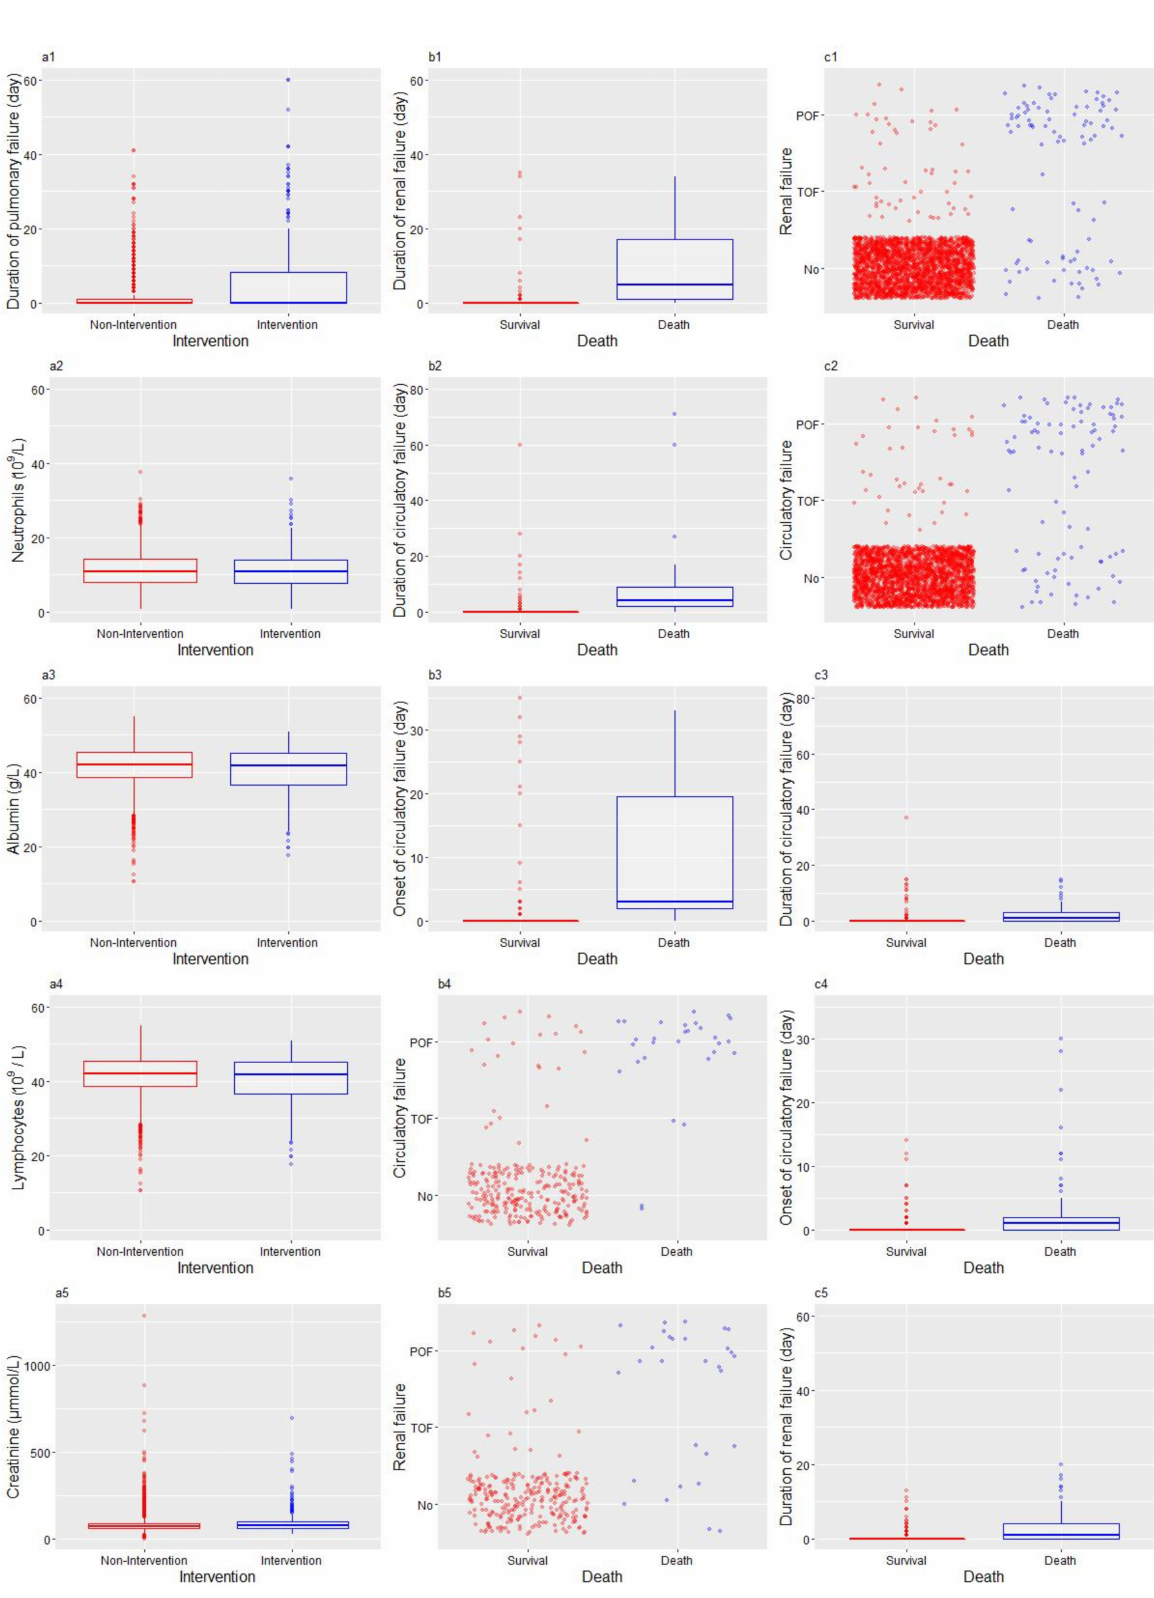
Figure 2. The relationship between important variable (the top five) and outcome. The first column ( a1 – a5 ) displays the top features for intervention, the second column ( b1 – b5 ) is for death in the intervention group, and the third column ( c1 – c5 ) is for death in the non-intervention